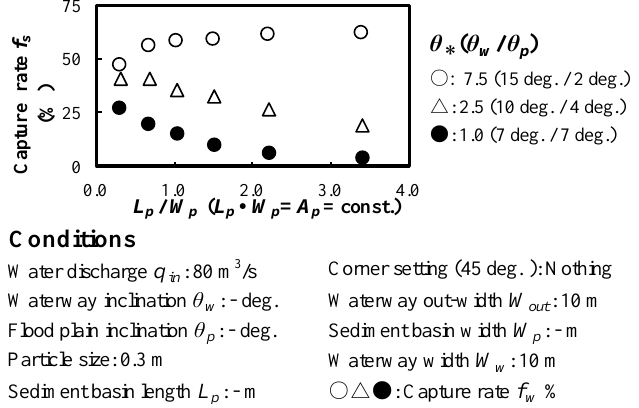
Figure 28. Effects of changes in the planar shape and gradient of the sediment retarding basin on sediment capture.